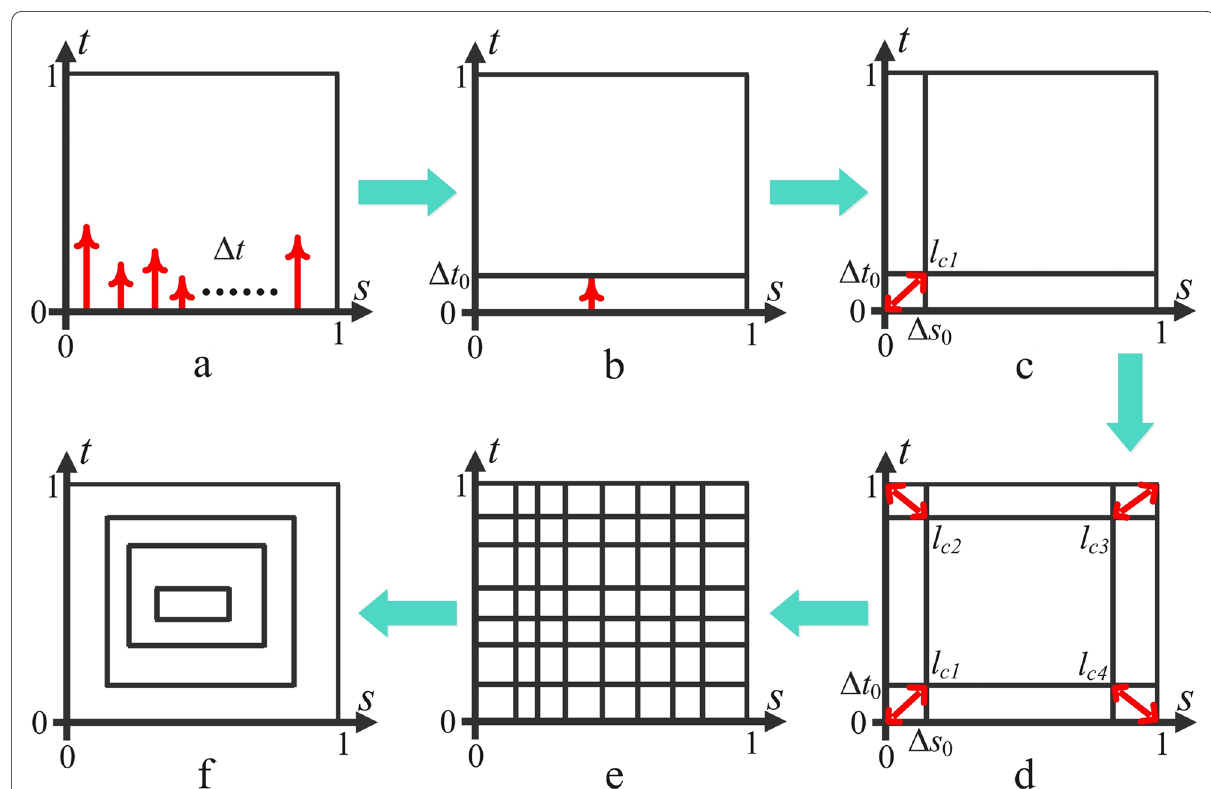
Fig. 15 Pipeline of the tool path generation method. a The offset interval of each sample point; b The minimum interval is selected to obtain the parametric line; c , d Adjust the intersection point to satisfy the scallop height constraint; e Offset the parametric lines until the entire parameter plane is filled; f Generate the contour tool